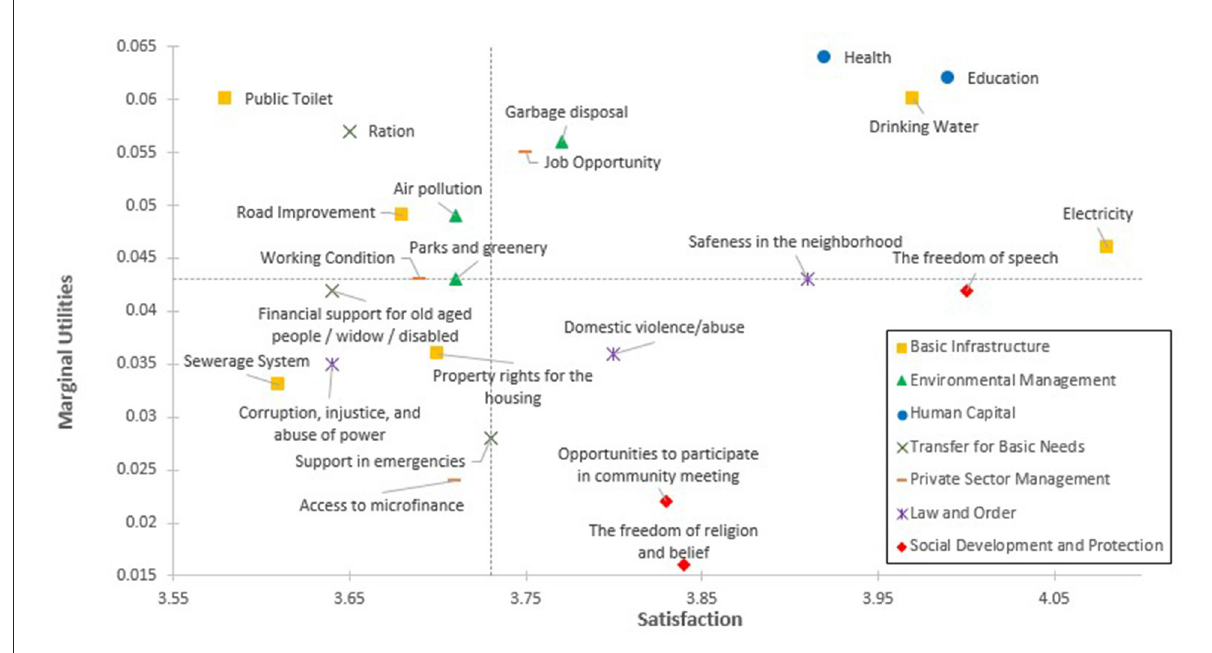
FIGURE1 Marginal utilities and satisfaction with public